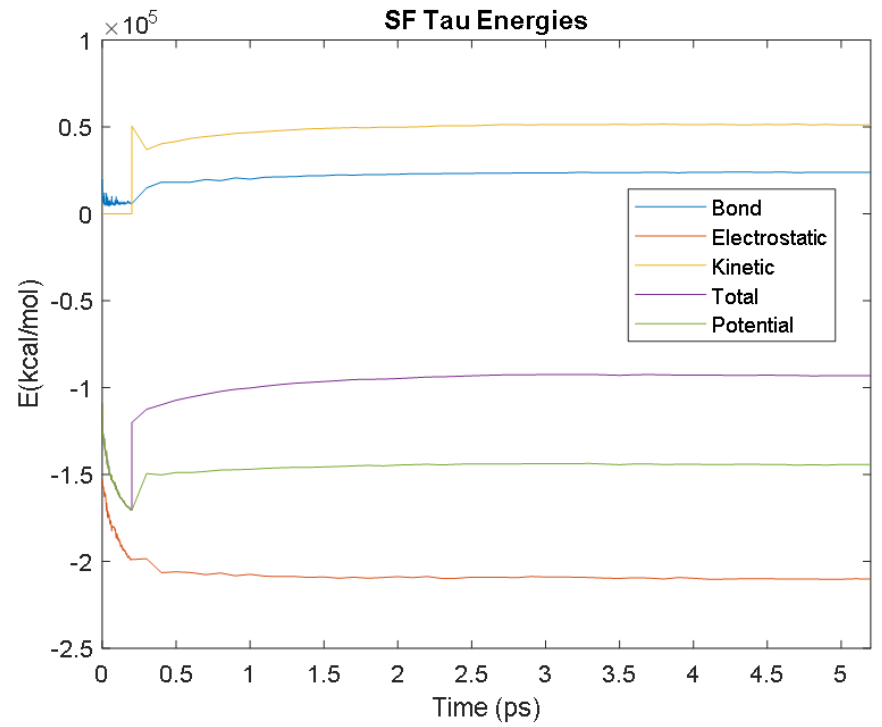
Figure 31. A plot of SF tau’s bond, electrostatic, kinetic, total, and potential energies.